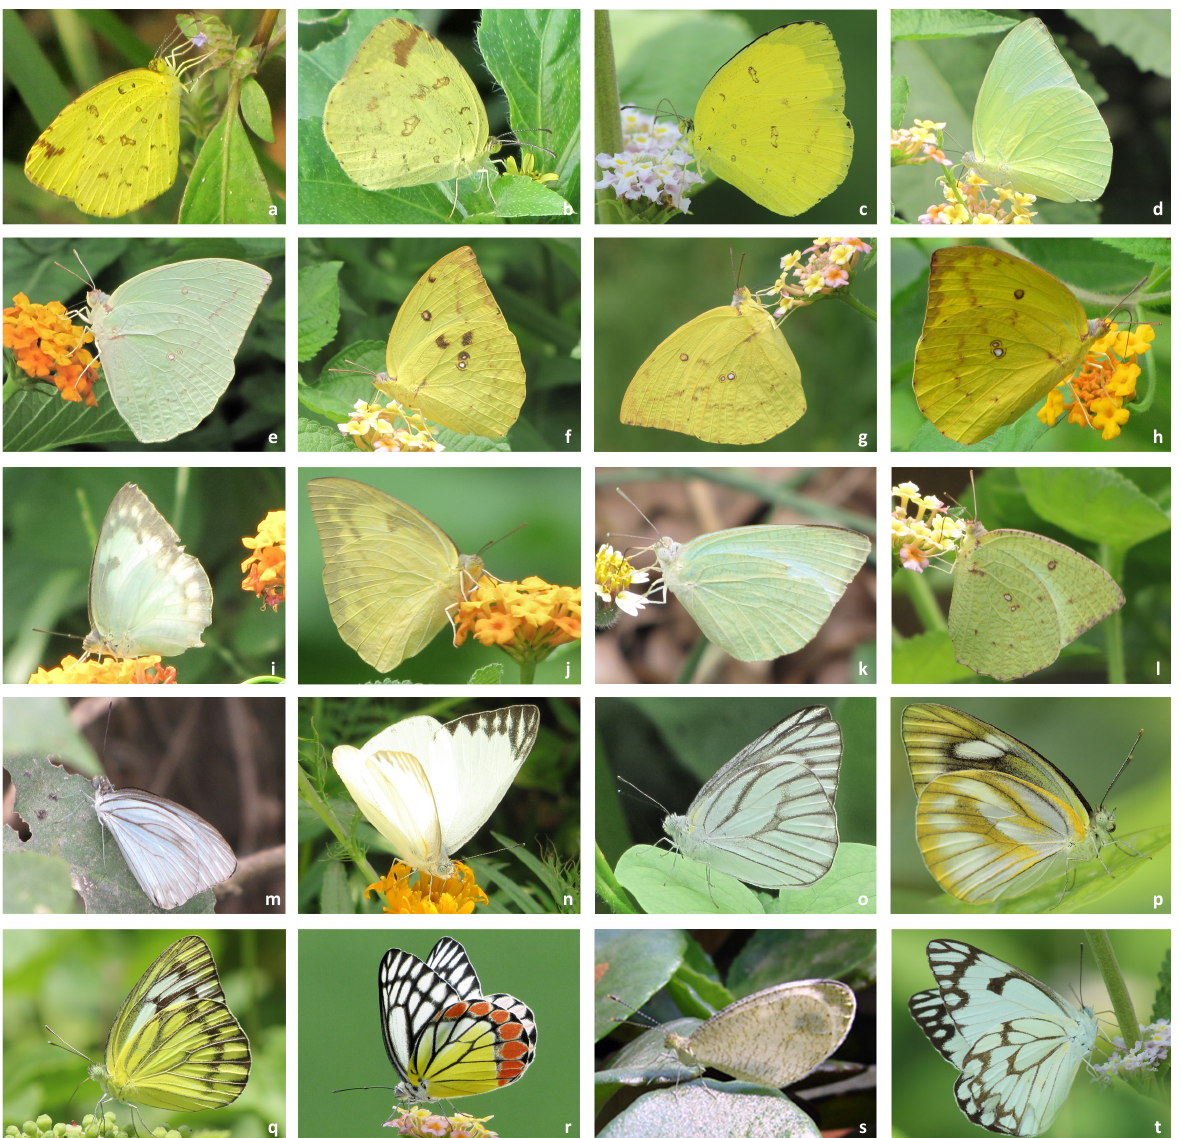
Image 3. Butterflies representing the family Pieridae in and around RRS, Chinsurah. a - One Spot Grass Yellow E. andersoni (Moore); b - Three Spot Grass Yellow E. blanda (boisduval); c - Common Grass Yellow E.